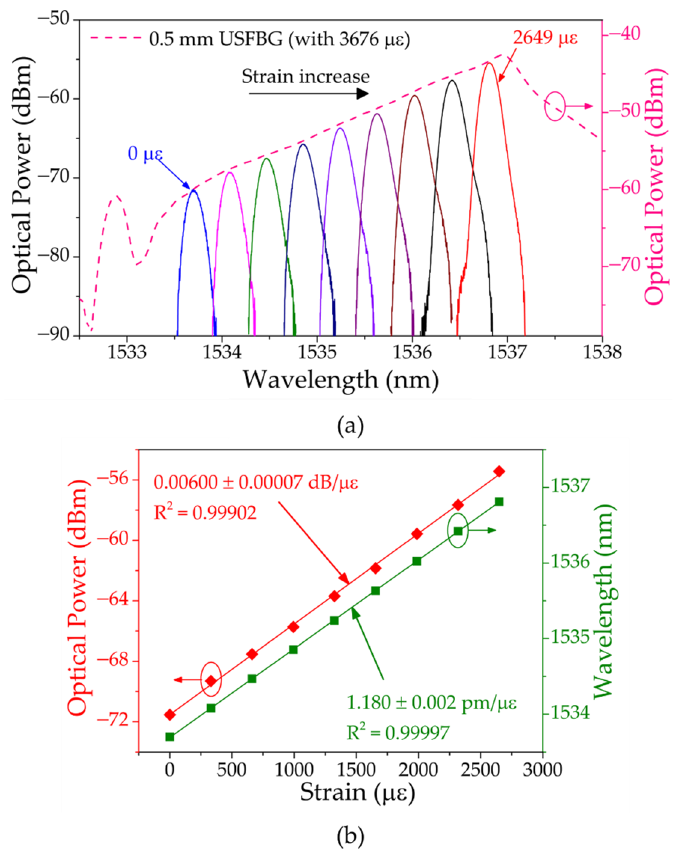
Figure 9. ( a ) Reflection spectra of the resulting signal at different levels of strain on the uniform FBG fiber and of the USFBG with 3676 µ ε . ( b ) Corresponding wavelength and optical power shift with increasing strain.